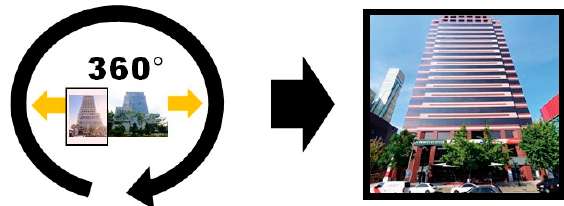
Figure 6. Road-View Image [10].